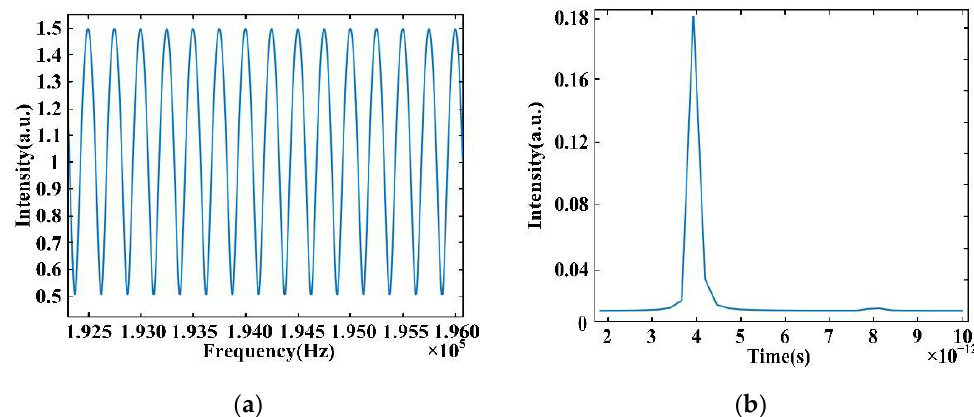
Figure 3. Simulation results of dispersion interference: ( a ) envelope of dispersion interference signal and ( b ) FFT results of dispersion interference.